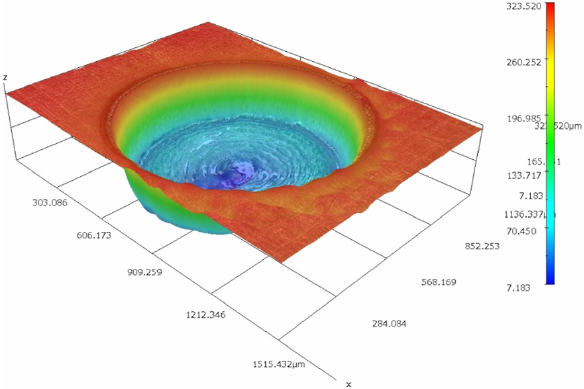
Figure 9: 3D profile of the third sample for trajectory No.